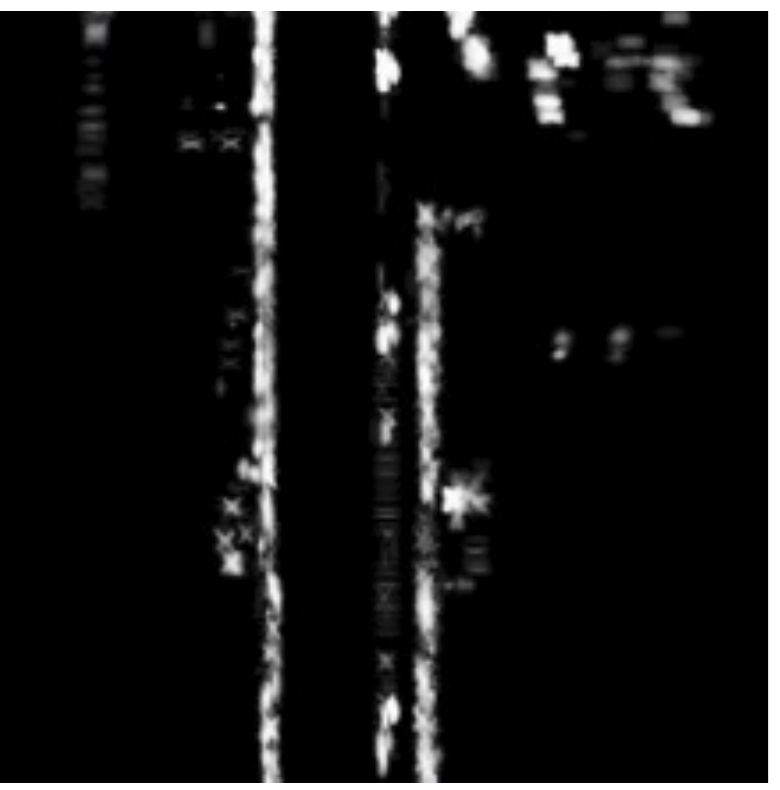
Figure 7. Radar map. The resolution is the same as the LiDAR map. Each pixel represents the existence probability of a stationary object at that point, with a white pixel representing a higher probability, i.e., the existence of an